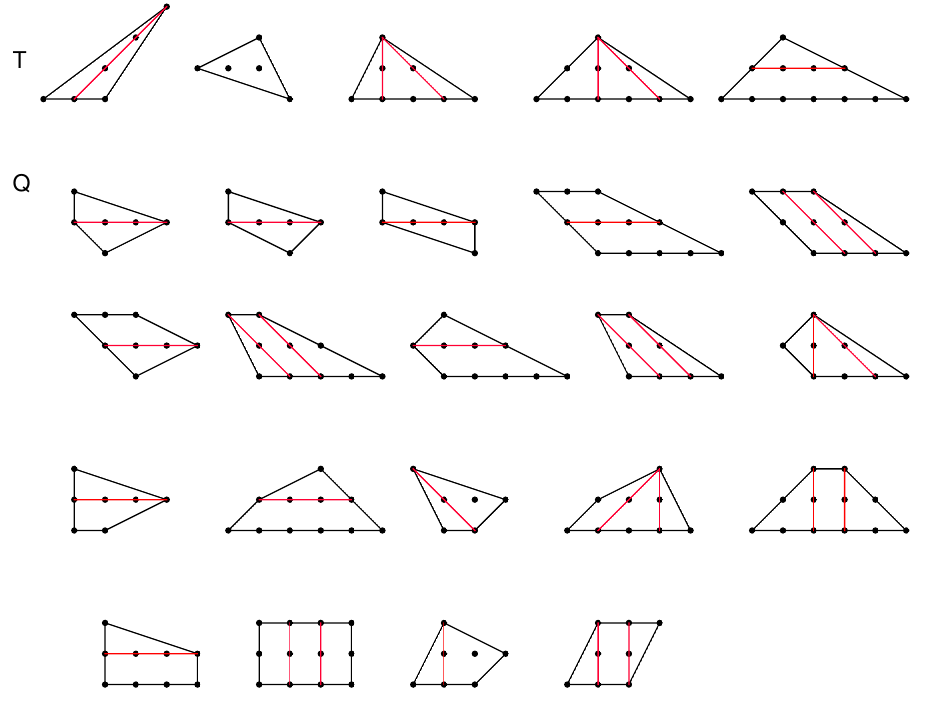
Figure 15 . Part A of toric diagram of rank two theory. The red lines indicate the partial resolution which give a gauge theory description.